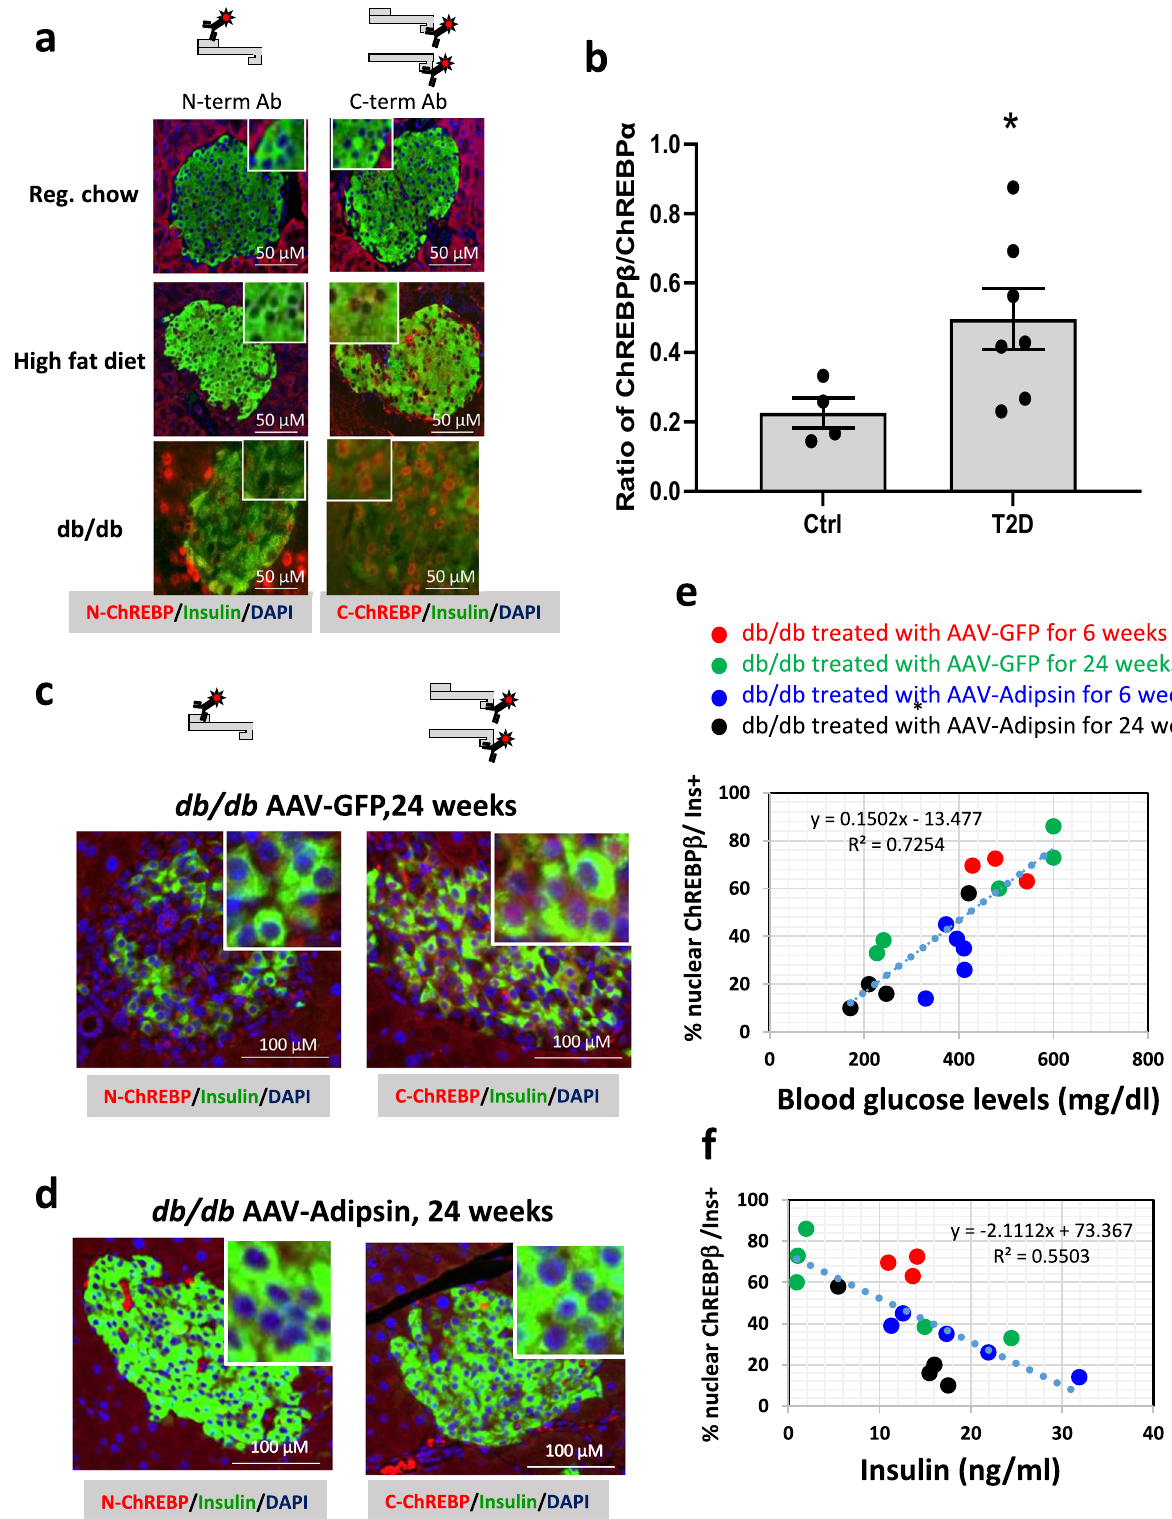
Fig. 3 | ChREBP β expression and nuclear localization correlates with adaptive expansion of β -cells and with glucose toxicity in diabetes. a The N-terminal or theC-terminalantibodiesrecognizingChREBPwereusedtostainpancreatictissue slices from C57Bl/6 mice fed on a standard chow diet, or fed a high-fat diet for 1 week, or from db/db diabetic mice. All micrographs represent at least 3 inde- pendent experiments. b Ratio of expression of ChREBP β to ChREBP α FPKM from RNAseq performed from FACS-sorted human β -cells isolated from non-diabetic ( n =4) and Type 2 diabetic subjects ( n =7). Each data point represents a different